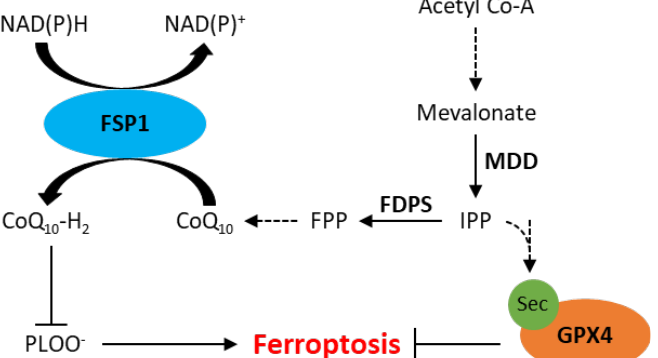
Figure 2. Schematic representation of the mevalonate pathway and its role in inhibition of ferropto- sis. CoQ 10 , ubiquinone; CoQ 10 -H 2, ubiquinol; FDPS, farnesyl diphosphate synthase; FPP, farnesyl phosphate; FSP1, ferroptosis suppressor protein 1; GPX4, glutathione peroxidase 4; IPP, isopentenyl phosphate; MDD, mevalonate diphosphate decarboxylase; PLOO−, lipid peroxyl radicals; Sec, sele- nocysteine. Dotted arrows represent multiple steps within a pathway.